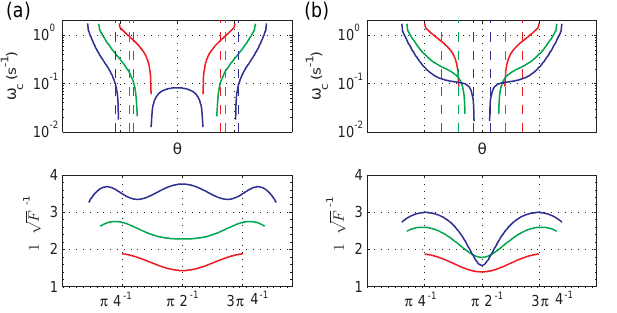
Figure 9. The parameter ω c and the adiabatic growth and decay fac- tor as a function of θ for various L values of the poloidal transverse mode for the compressed-dipole field with (a) φ = 0 and (b) φ = π , respectively. Format is the same as Fig. 1. The broken part of some curves in top panels corresponds to ω 2 c < 0.